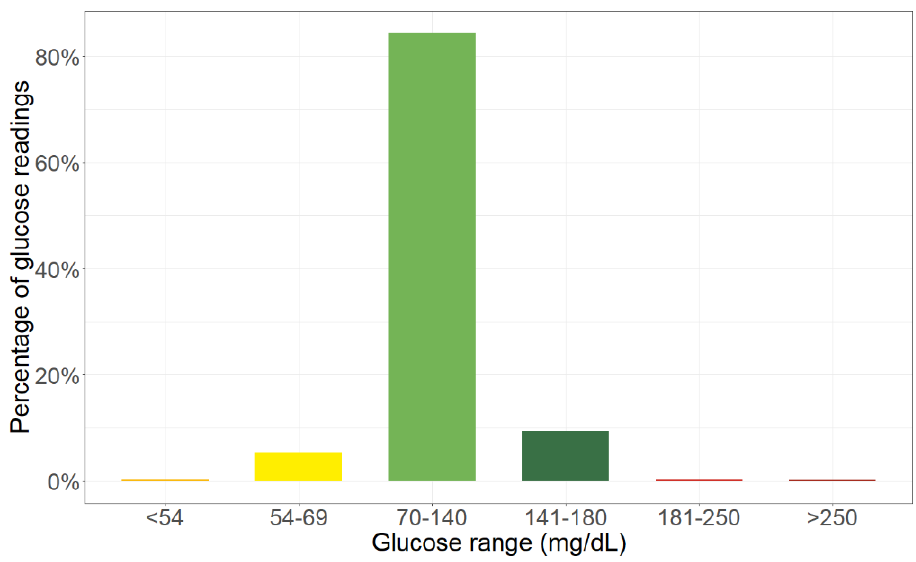
Figure 3. Bar representation of average time in ranges. Specifically, four patients reveal glycemic fluctuations over the 180 mg/dL threshold of hyperglycemia, as shown by the time series chart in Figure 4.